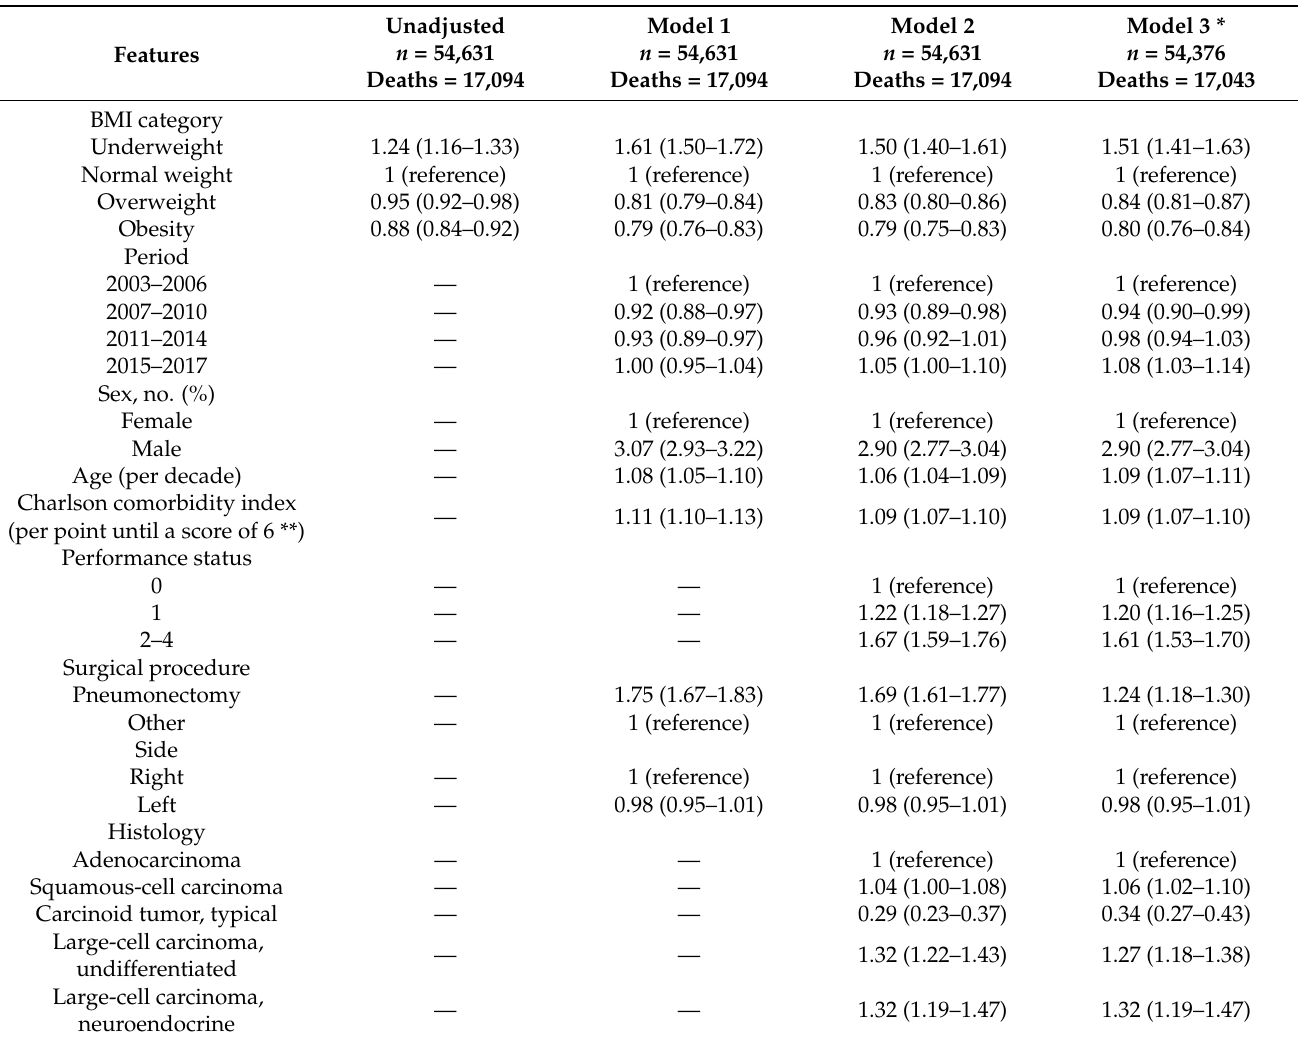
Figure 2. Kaplan–Meier survival curves of patients with resected lung cancer with respect to BMI. ( A ) Women. ( B ) Men. Table 2. Association of body mass index categories with survival. Results presented are pooled hazard ratios over the imputed datasets with 95% confidence